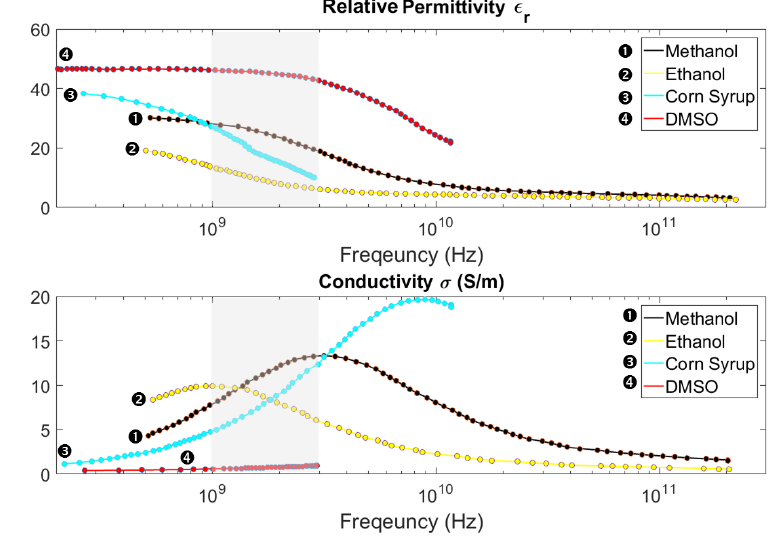
Figure 4. Relative permittivity and conductivity of four selected liquids. The frequency range of the system presented here (1–3 GHz) is shaded in gray. Data is taken from [125,126,133,139],